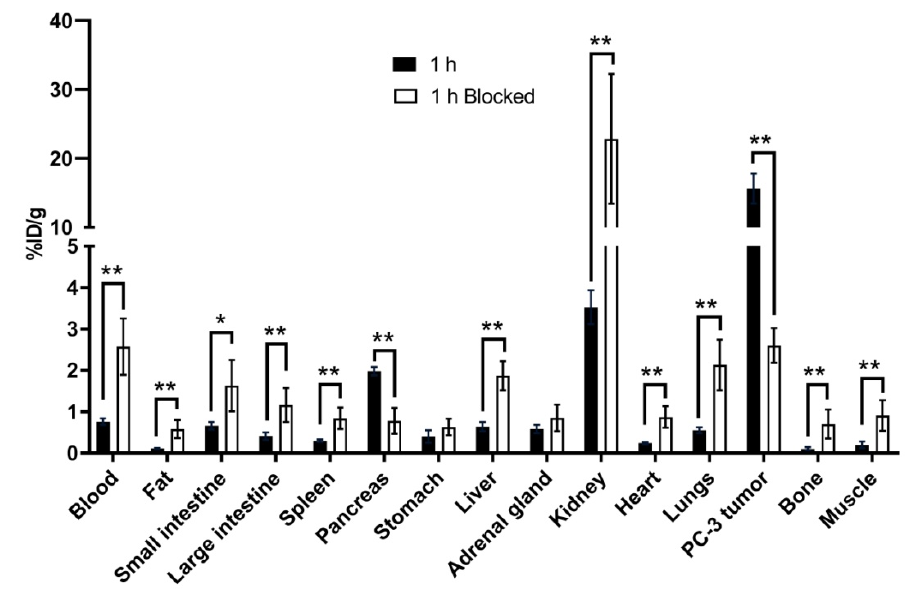
Figure 7. Comparison of [ 68 Ga]Ga-TacsBOMB5 with/without co-injection of nonradioactive standard on the uptake in PC-3 tumor xenografts and major organs/tissues in mice at 1 h post-injection. Error bars indicate standard deviation. * p < 0.05, ** p < 0.01.